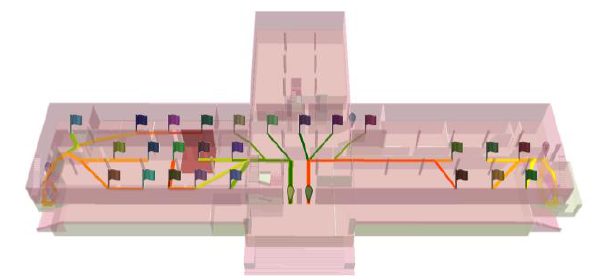
Figure 31. Generated Evacuation Ground Floor Routes of Library Patrons for Third Evacuation Scenario